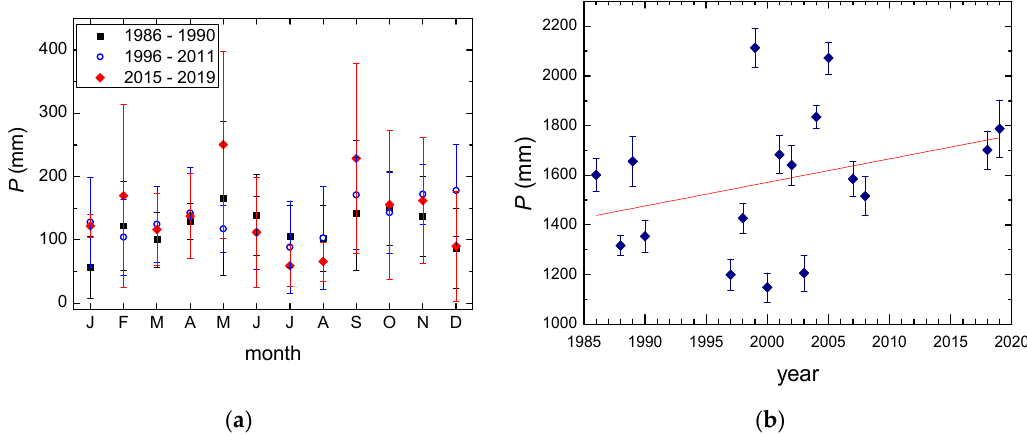
Figure 4. ( a ) Monthly mean precipitation amount at the Plitvice lakes meteorological station in the three periods when data are available; ( b ) annual precipitation amounts at the Plitvice Lakes in 1986–2019 (only years with complete data for 12 months are shown).